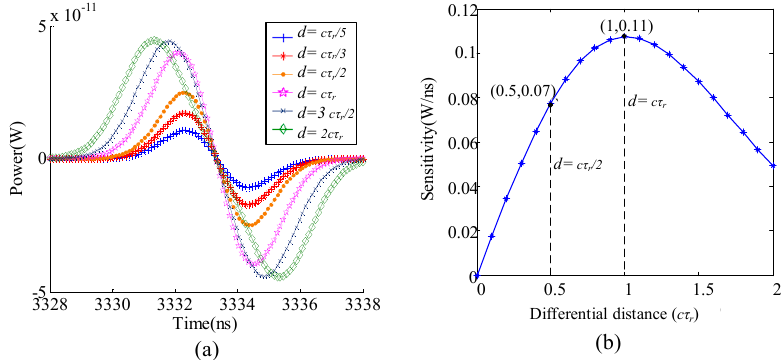
Figure 12. The performance of the time slice under different differential optical paths. ( a ) Echo signal power vs. time. ( b ) Sensitivity vs. differential distance.